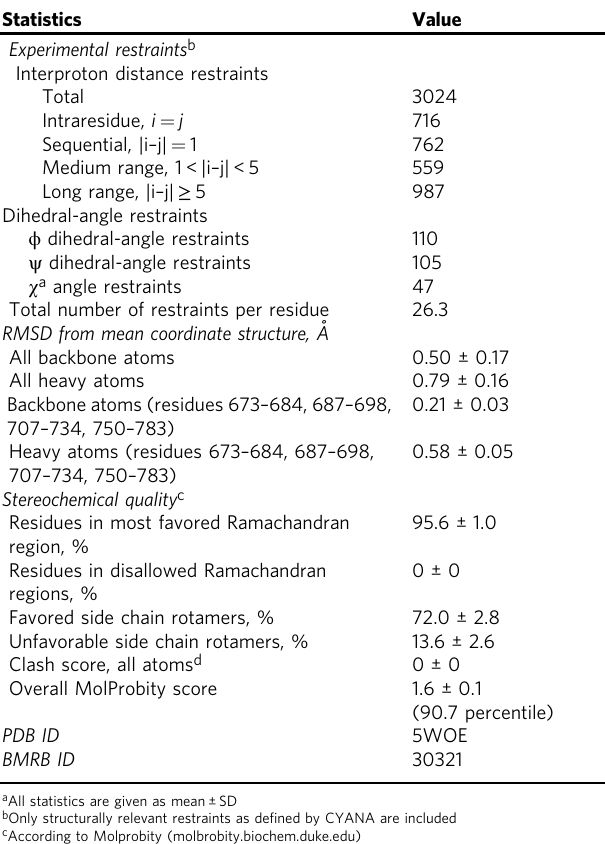
Table 2 Structural Statistics of NMR Structure of the